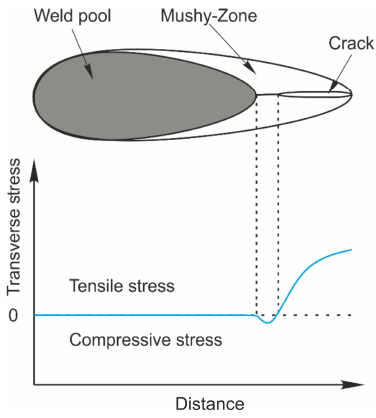
Figure 1. Representation of the influence of the transverse stress development on the hot cracking, according to [6].